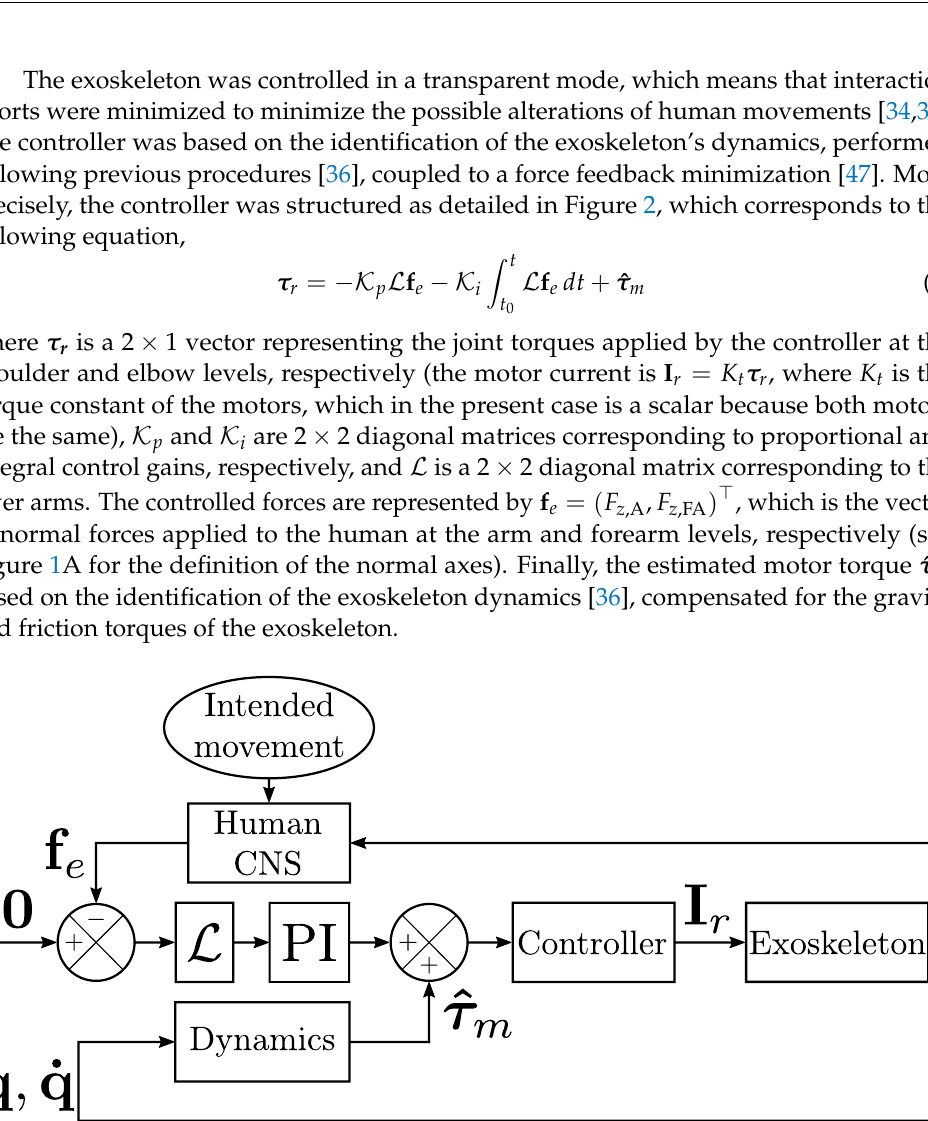
Figure 2. Control structure of the exoskeleton (see the description of Equation (1) for the definition of the